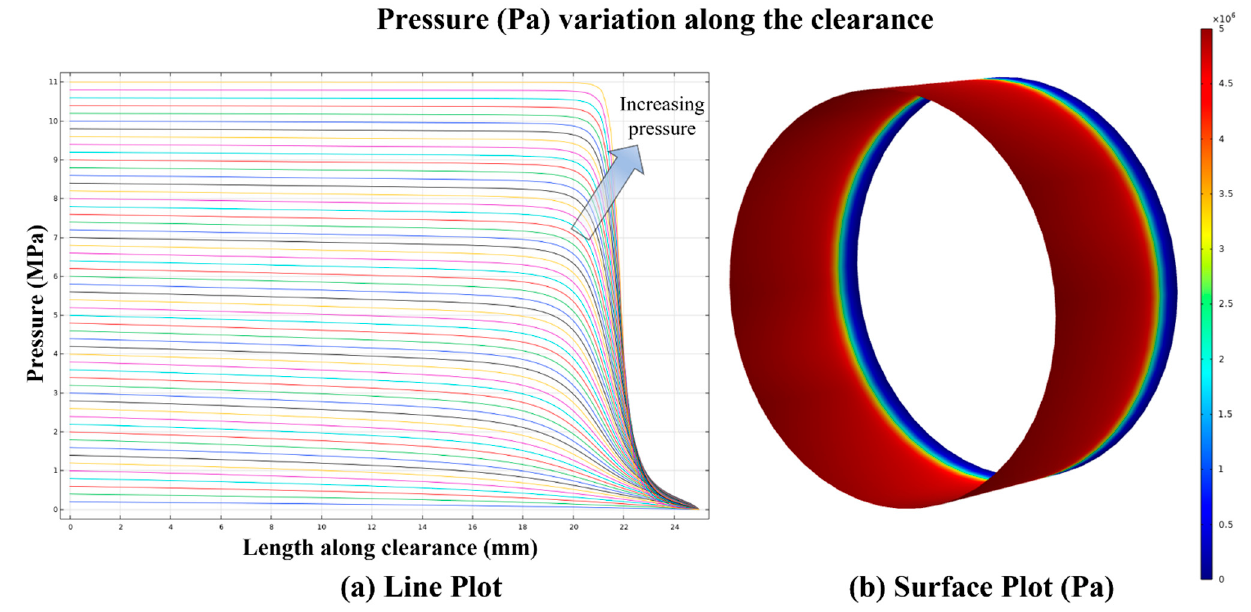
Figure 6. ( a ) Line plot of the pressure variation along the clearance for various inlet pressure conditions between 1 MPa and 11 MPa in intervals of 1 MPa. The inlet pressure value for each curve is the value on the corresponding curve at x = 0. ( b ) Surface plot of the pressure variation in the thin film between the rotor and sleeve at P 0 = 5 MPa.